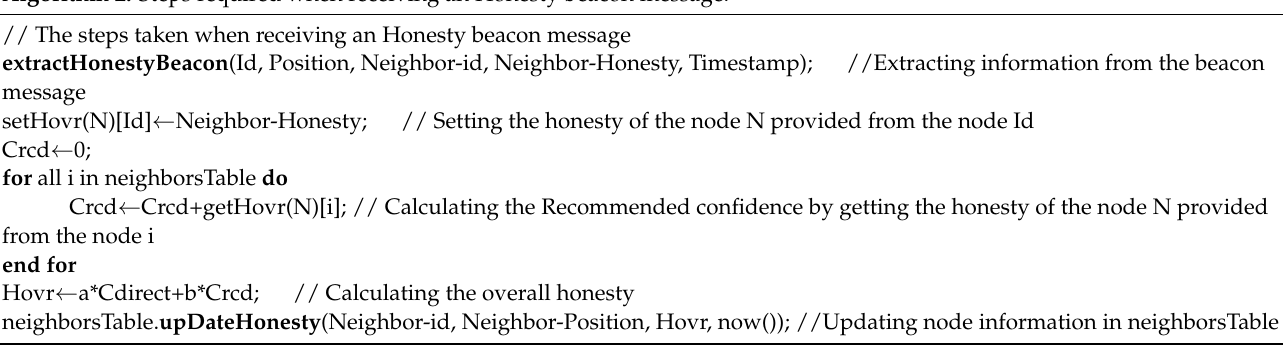
Algorithm 2. Steps required when receiving an Honesty beacon message. // The steps taken when receiving an Honesty beacon message